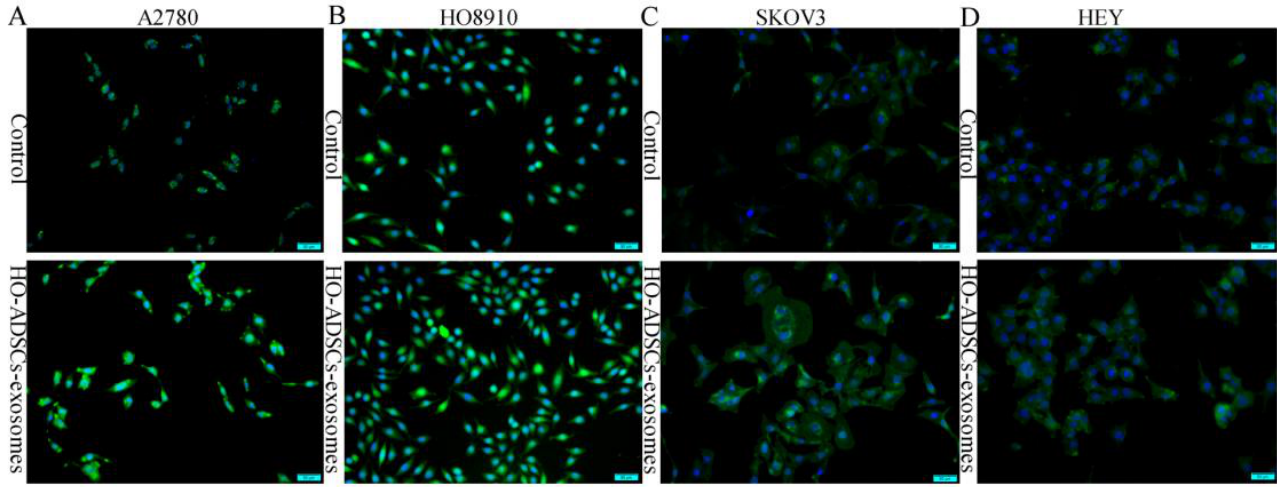
Figure 5. FOXM1 fluorescence expression in human EOC cells after treatment with HO-ADSC exosomes. Cell immunofluorescence was performed to evaluate the expression of FOXM1 (green) in EOC cells, and nuclei were stained with DAPI (blue). ( A ). Representative image of FOXM1 staining in A2780 cells in vitro. ( B ). Representative image of FOXM1 staining in HO8910 cells in vitro. ( C ). Representative image of FOXM1 staining in SKOV3 cells in vitro. ( D ). Representative image of FOXM1 staining in HEY cells in vitro.